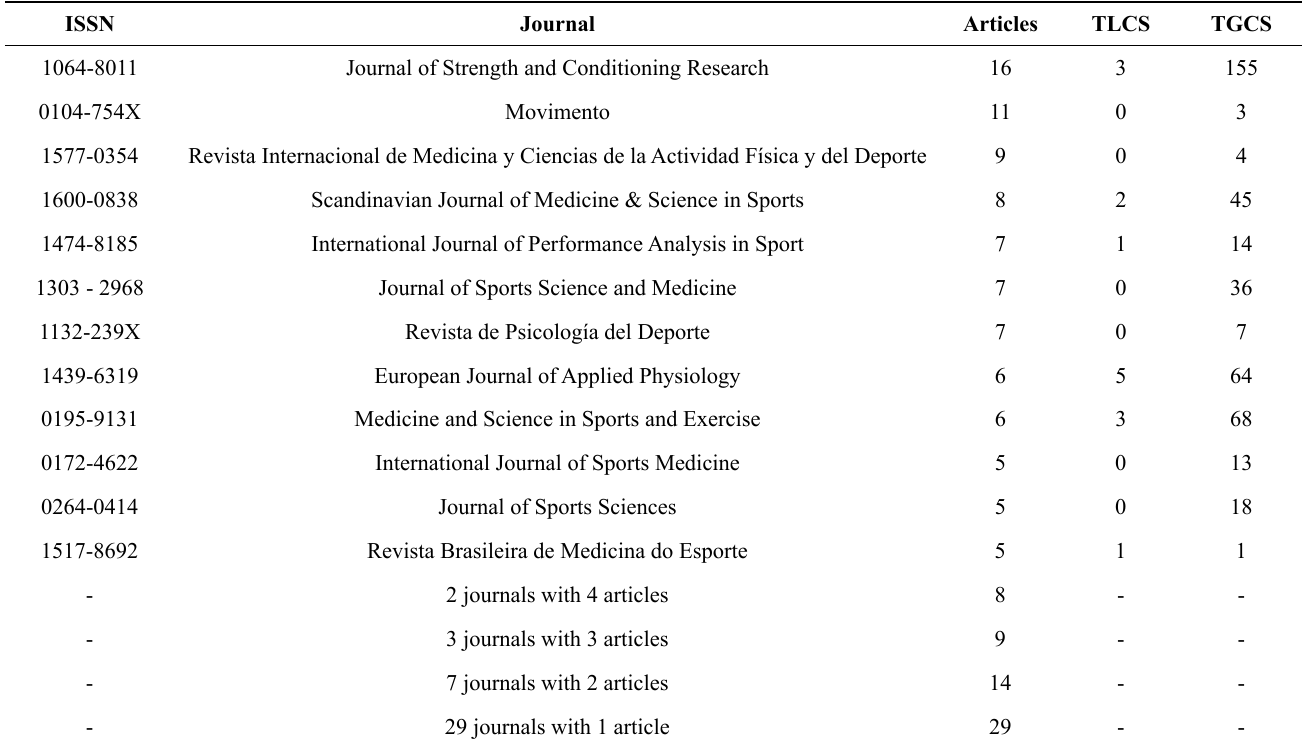
Table 5 - Source journals for the articles and